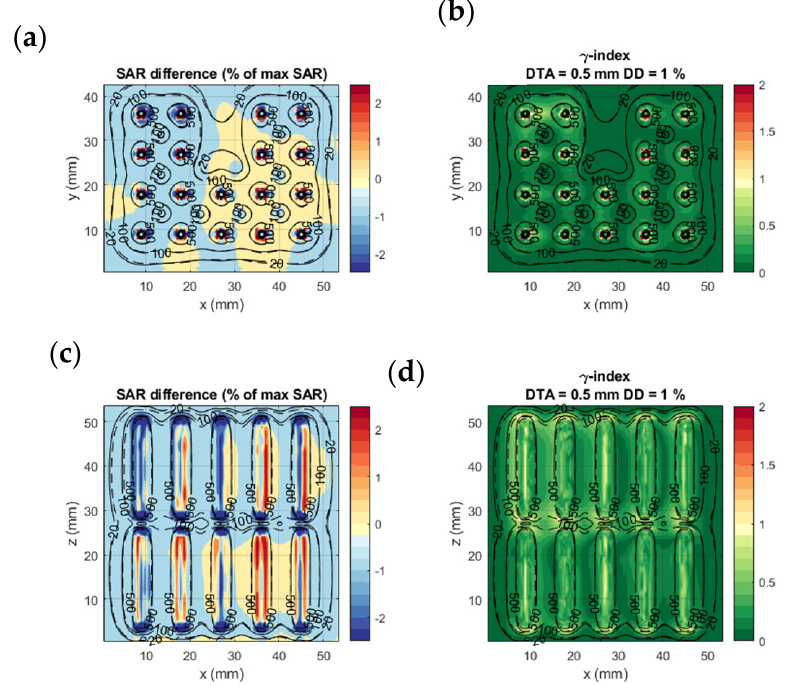
Figure 5. Homogenous benchmarking model: SAR difference between calculation method 1 and